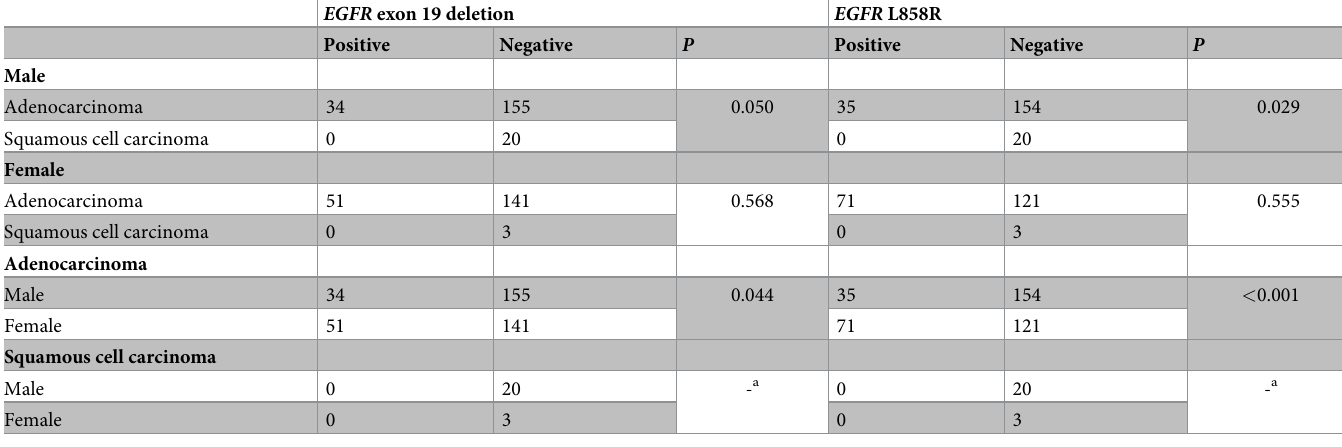
Table 7. Comparison of EGFR exon 19 deletion and L858R between adenocarcinoma and squamous cell carcinoma in different gender, and between male and female patients in adenocarcinoma or squamous cell